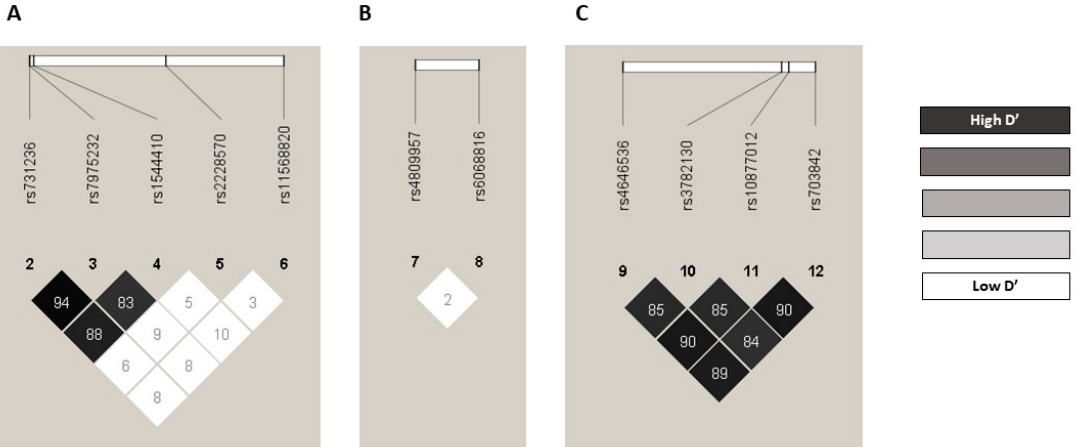
Figure 1. Pairwise LD D’ plots for SNPs located in VDR gene, CYP24A1 gene, and CYP27B1 gene in the whole population. Numbers inside the squares are the D’ values expressed as a percent: ( A ) pairwise LD D’ plots for 5 SNPs located in VDR gene, ( B ) pairwise LD D’ plots for 2 SNPs located in CYP24A1 gene, and ( C ) pairwise LD D’ plots for 4 SNPs located in CYP27B1 gene. LD: linkage disequilibrium; SNP: single nucleotide polymorphism.